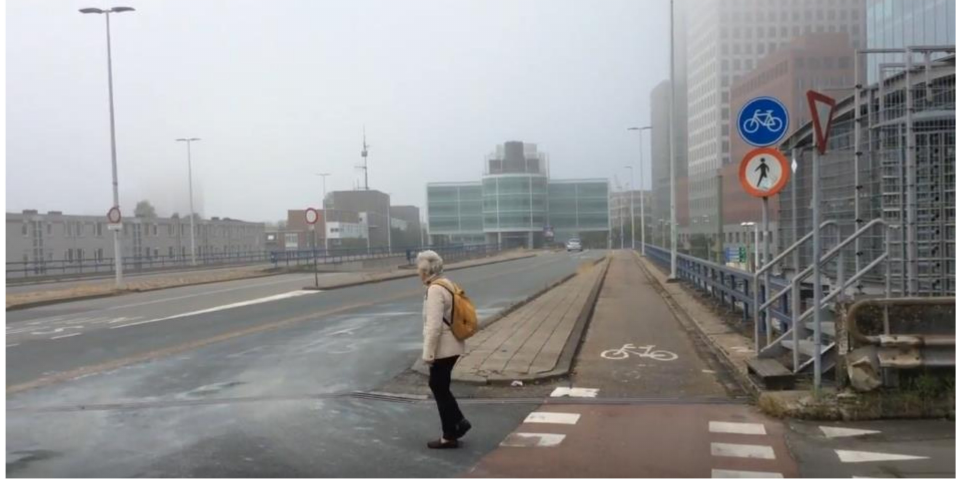
Figure 1. Video fragment: Outdoor spaces in The